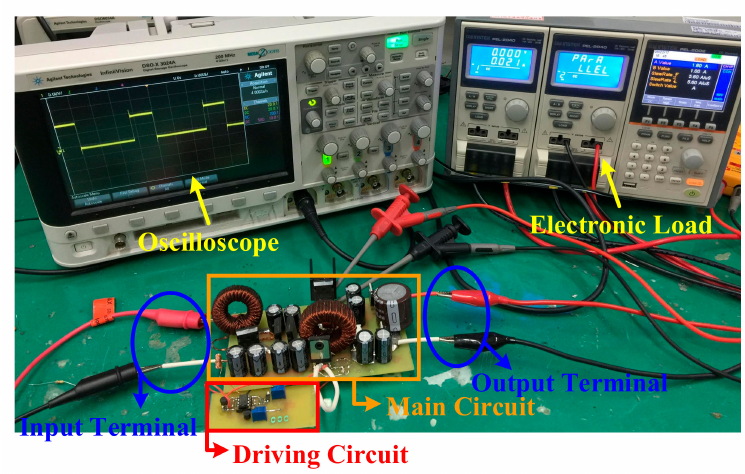
Figure 11. The photo of the experimental